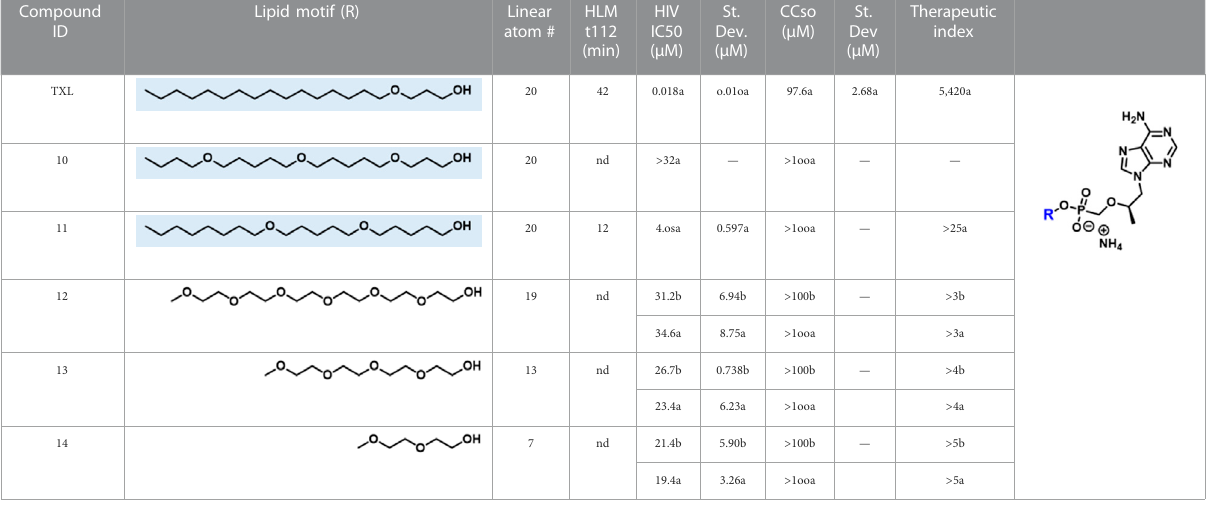
TABLE1 Invitro activitypro fi lesoflipidprodrugs ofTFVcontaining increasingoxygen content.HIVandcytotoxicity results represent datagenerated(a)with compounds formulated as HSA complexes in 5:1 M ratios or (b) using DMSO stock solutions. Nd, not determined. Lipid motif Compound ID